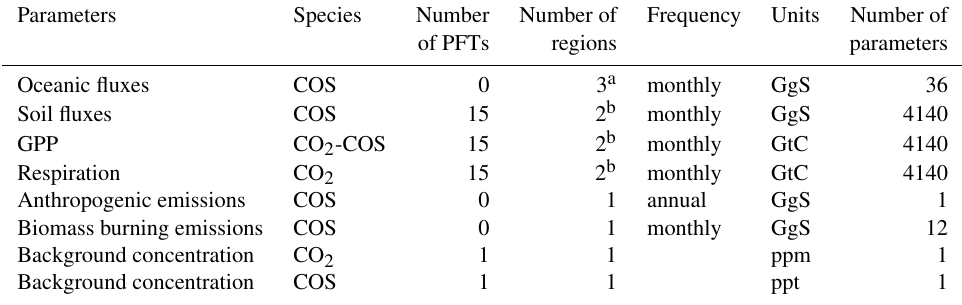
Anthropogenic emissions Biomass burning emissions Background concentration Background concentration